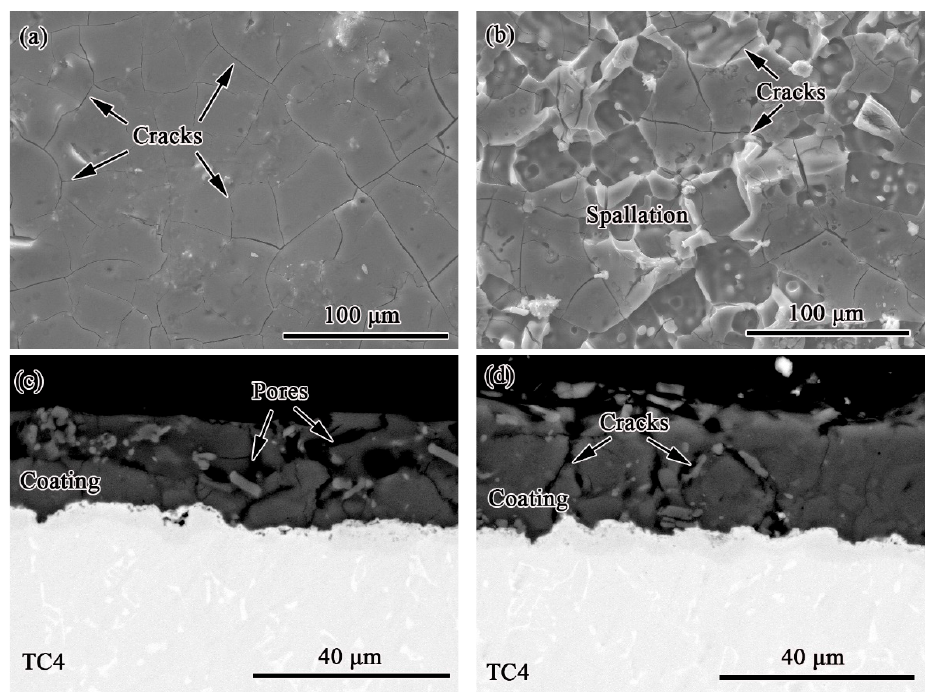
Figure 8. Surface ( a , c ) and cross ‐ sectional ( b , d ) morphologies of the SiO 2 ‐ Al 2 O 3 glass composite coat ‐ ing after corrosion in marine environment for 100 h at 650